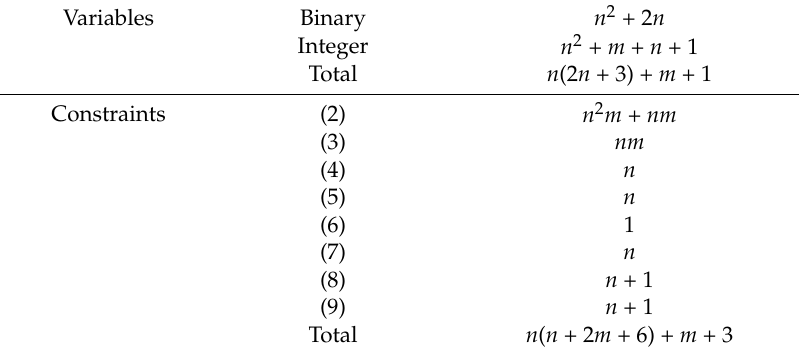
Table 1. Model’s size in relation to numbers of variables and